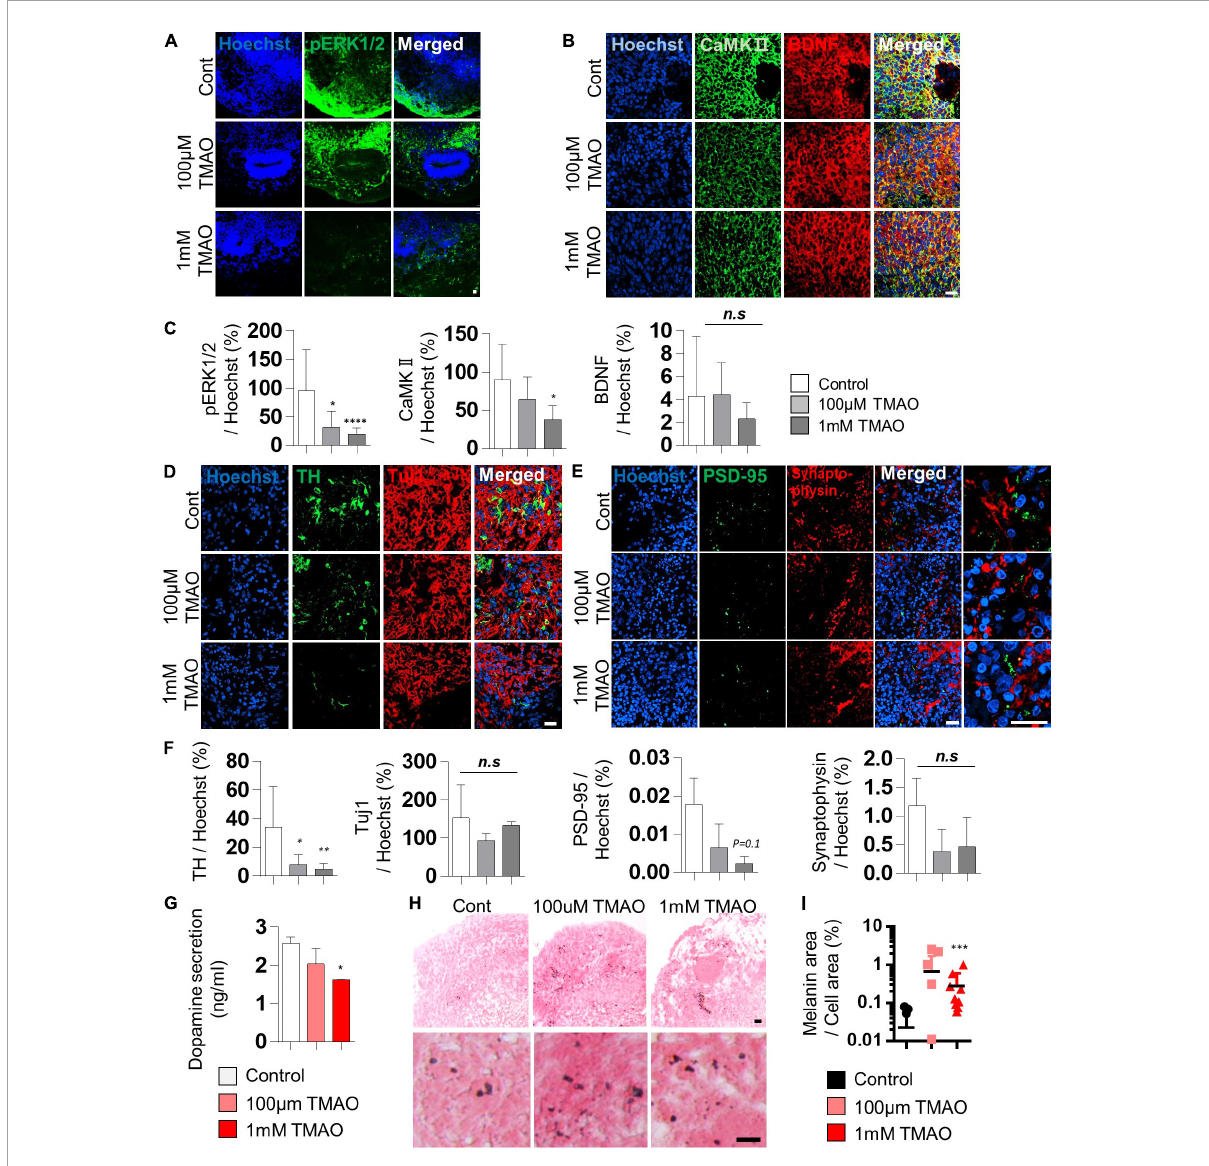
FIGURE3 Neurodegeneration phenotypes of trimethylamine N -oxide (TMAO)-treated midbrain organoids. (A,B) Representative IF images showing the ERK phosphorylation (A) and CaMKII/BDNF (B) in the indicated organoid group. Hoechst was used for counter nuclei staining. (C) Quantifications of the ERK phosphorylation (left), CaMKII (middle), and BDNF (right) in the indicated organoid group. (D,E) Representative IF images showing the TH- and TUJ-1 positive neurons (D) and synaptic marker expression (PSD-95 and Synaptophysin) (E) in the indicated organoid group. Hoechst was used for counter nuclei staining. (F) Quantifications of the TH, TUJ-1 (left), PSD-95, and Synaptophysin (right) in the indicated organoid group. (G) Quantification of dopamine secretion to conditioned media from indicated organoids. (H) Representative Fontana-Masson staining images for neuromelanin at 8 weeks of maturation in midbrain organoids. (I) Quantifications of Fontana-Masson staining. Data are AVE ± SD [ P < 0.05(*), P < 0.01(**), P < 0.001(***)]. (Scale bar = 20 µ